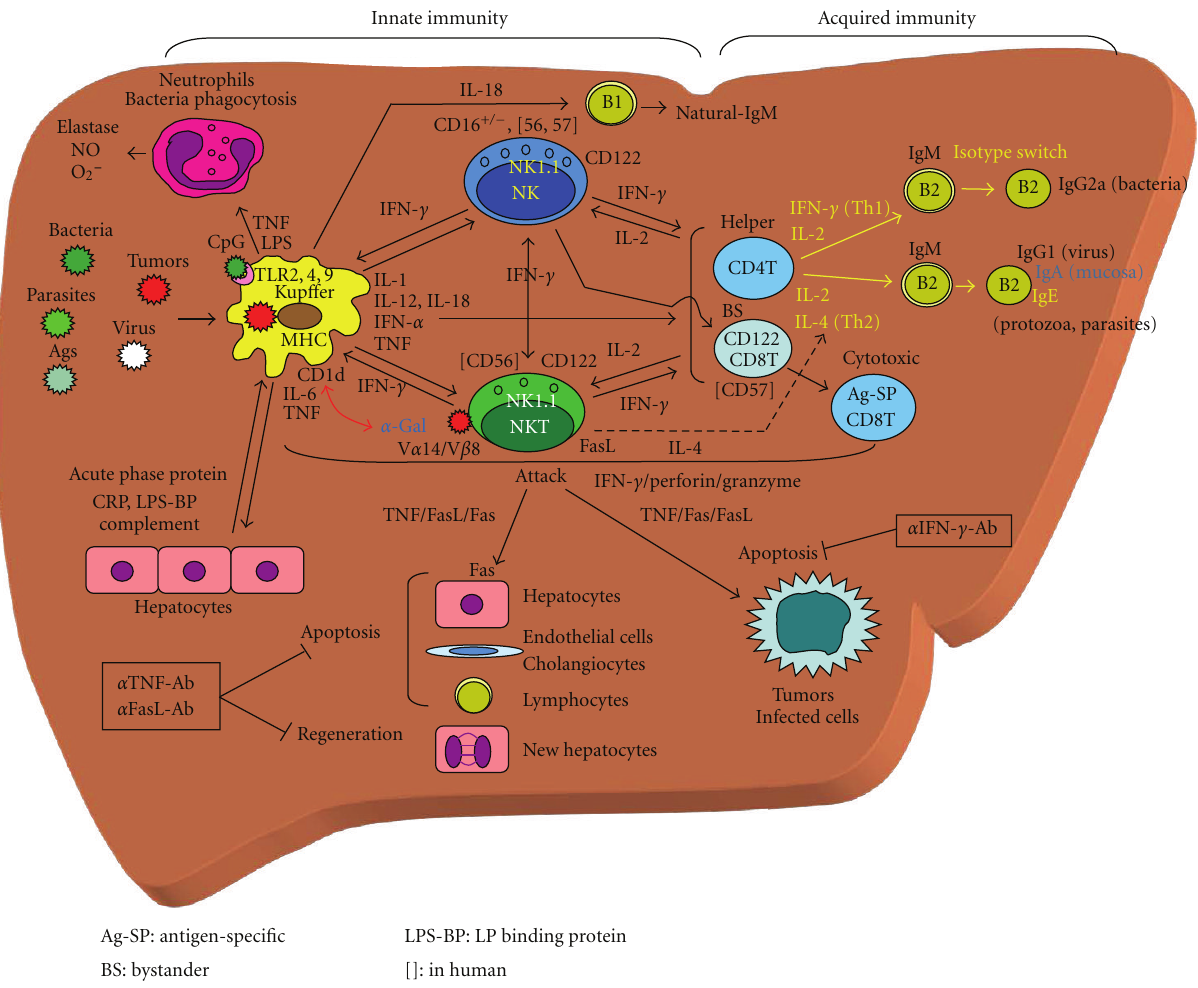
Figure 2: Scheme of immune responses in the